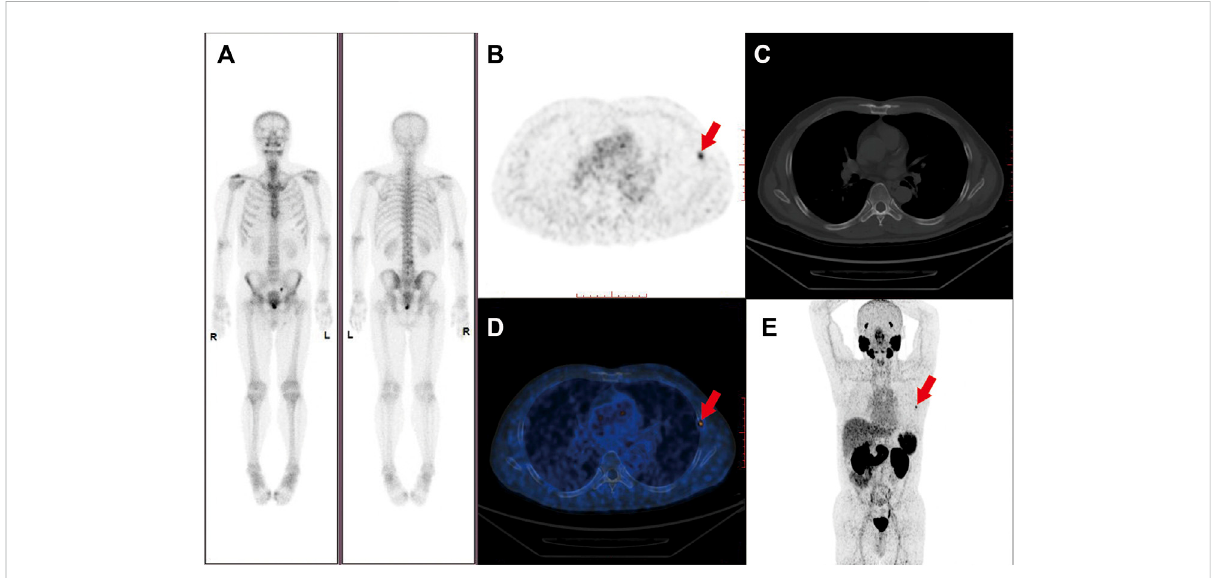
FIGURE 2 Imaging of a 56-year-old patient with Gleason score 7 prostate cancer and rising PSA following laparoscopic prostatectomy. PSA was 1.51 ng/ ml atthe time of the PET scan. PSMA-PET maximum-intensity projection,axial slides, and axial fused PET/CT revealed metastasis bone lesionon the left fi fth rib (where the red arrows pointed to) with a SUVmax of 5.1 (B,D,E) . The lesion was not detected on the (A) Bone scan and (C) CT scan performed